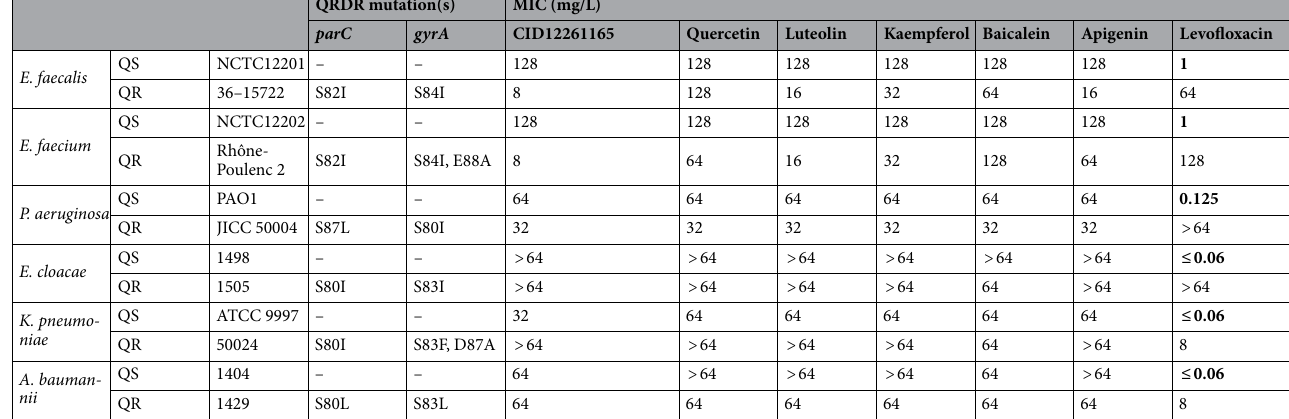
Table 3. Minimum inhibitory concentration of the flavonoids against QS and QR ESKAPE pathogens besides S. aureus and E. faecalis strains. QS quinolone susceptible, QR quinolone resistant. MICs ≤ 4 mg/L are in